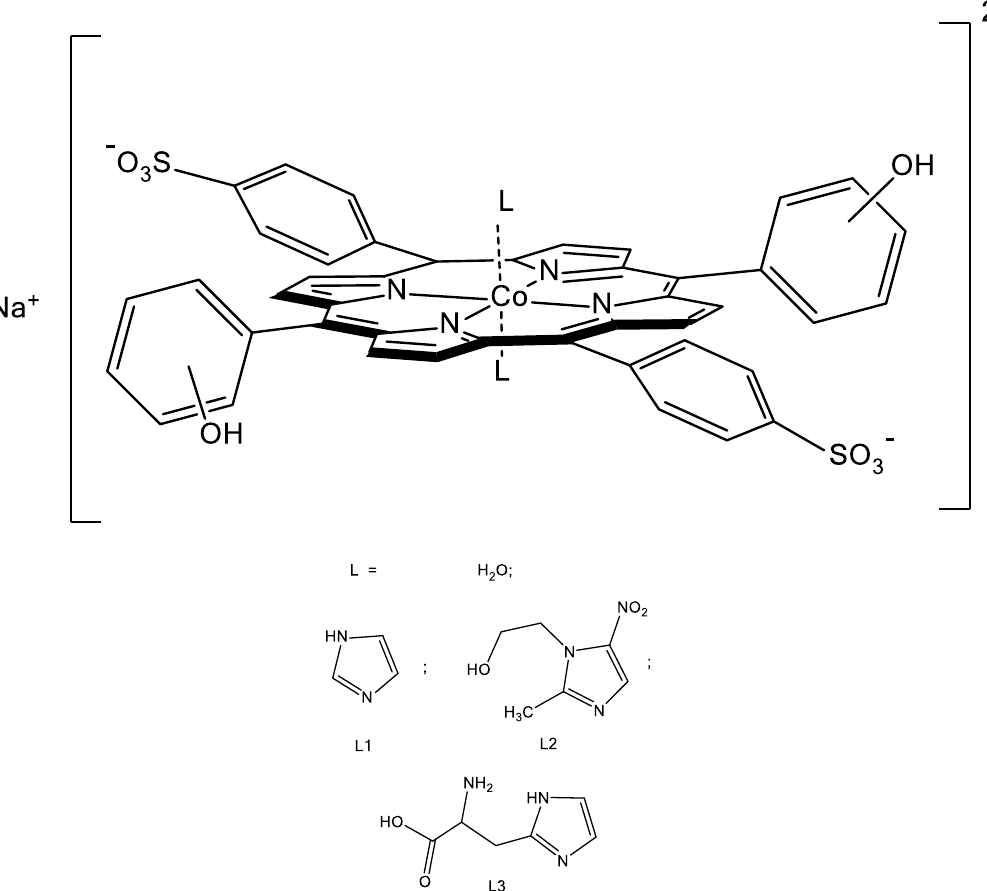
Figure 1. Structures of the Co(III)-porphyrins bis -axial complexes with the ligands (L = H 2 O,